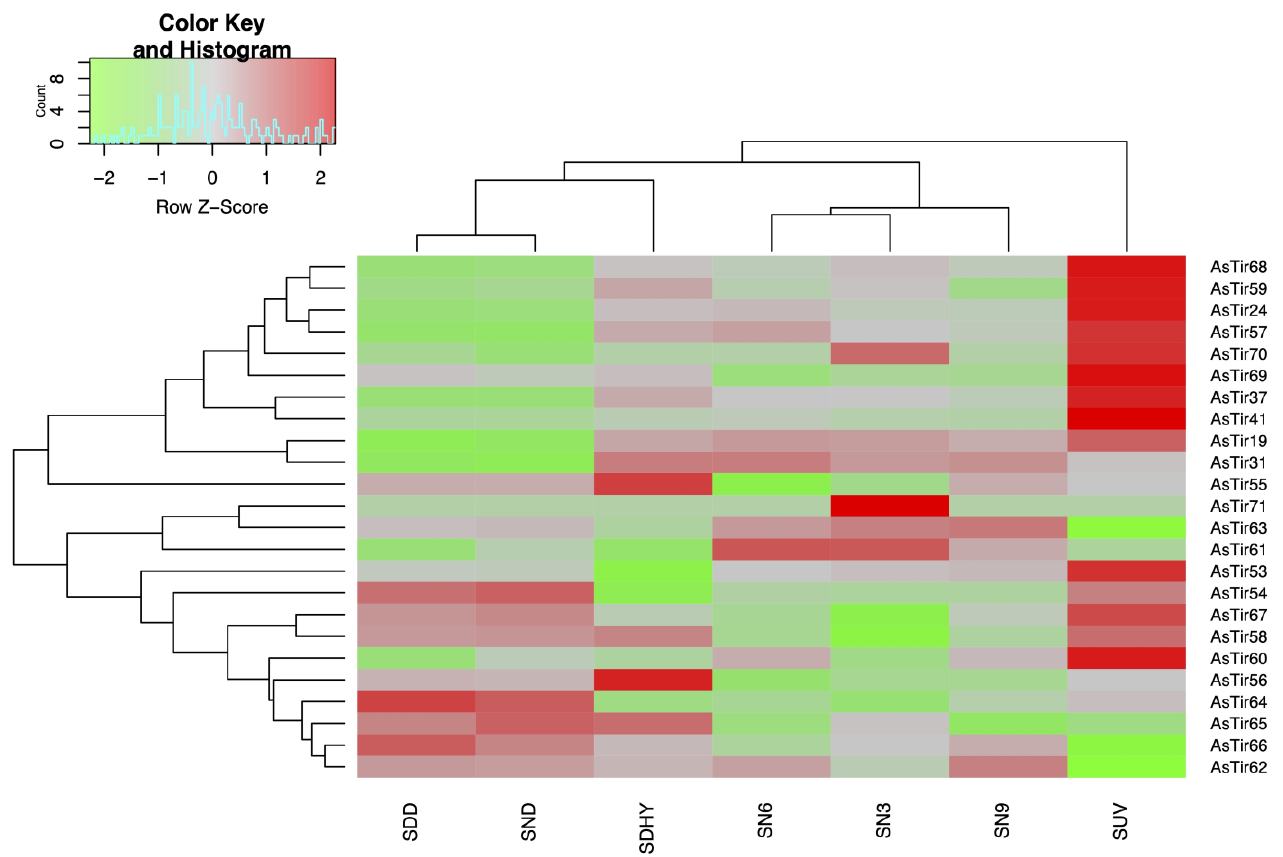
Figure 3. Heatmap of the relative RNA-Seq expression of 24 TNx genes from A. stenosperma plants subjected to biotic and abiotic stress treatments, with normalized log 2 FC values in a red-green scale (FDR < 0.05; log 2 FC). Plants submitted to: dry-down imposition (SDD); combined drought and nematode stresses (SND); dehydration treatment (SDHY), nematode infection for three, six and nine DAI (SN3, SN6, SN9) and UV exposure (SUV).